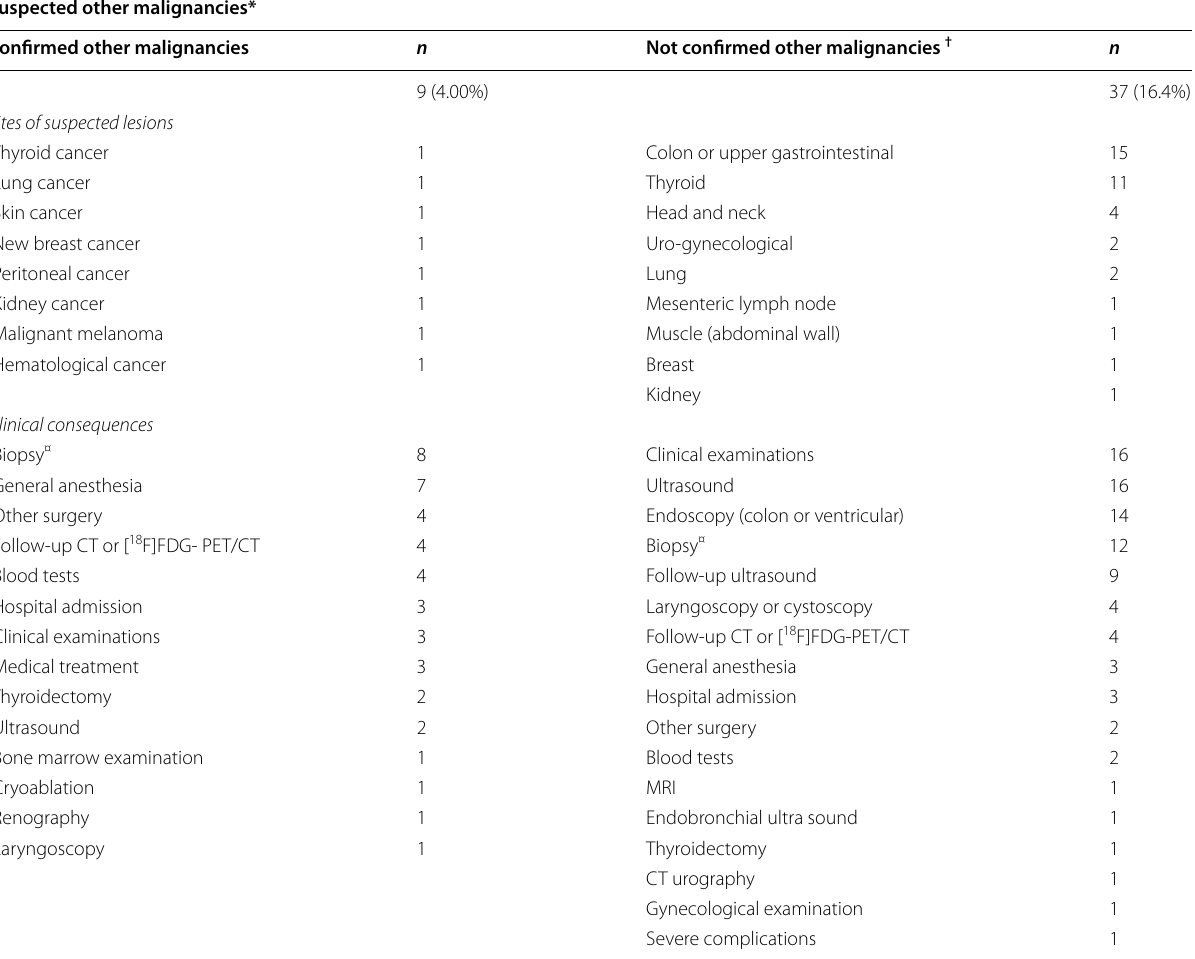
Table 3 Examinations performed after suspected incidental malignancies on [ 18 F]FDG‑PET/CT in women with confirmed and not confirmed findings ( n =